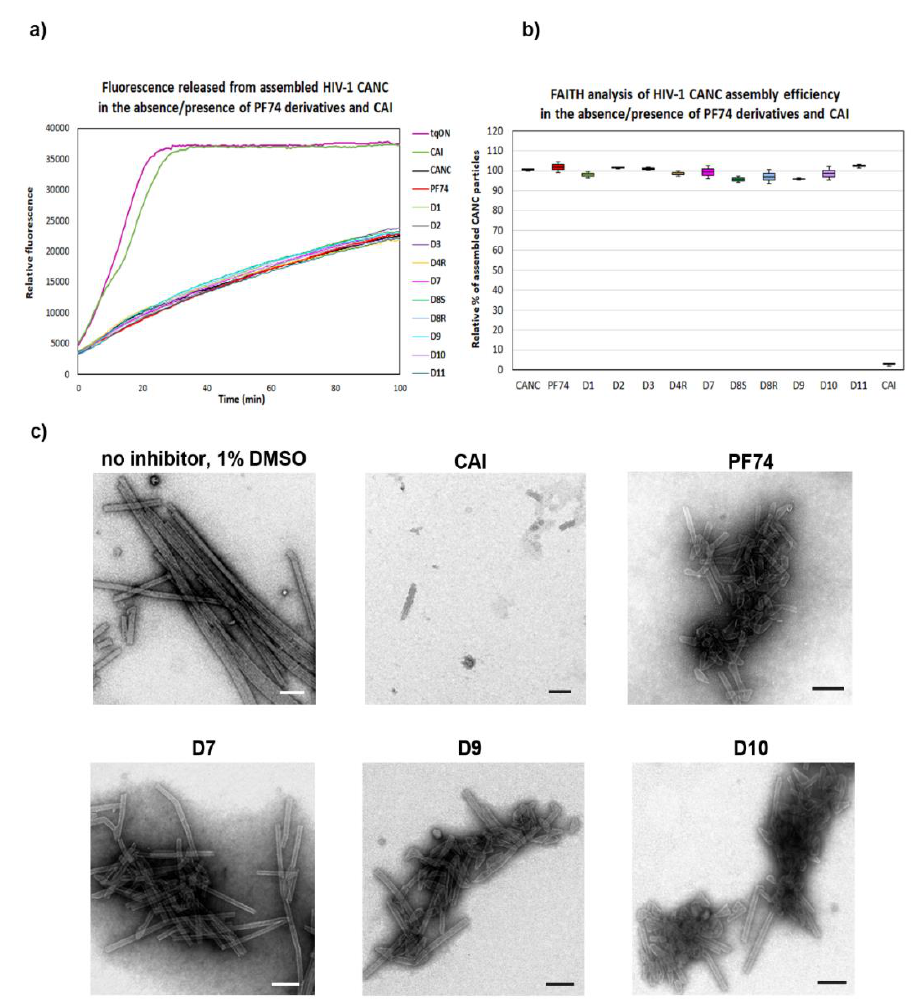
Figure 2. Quantification of the in vitro assembly of HIV-1 CANC in the presence of PF74 and its derivatives by Fast Assembly Inhibitor Test for HIV (FAITH). HIV-1 CANC (18 µM) was mixed with tqON (1.8 µM) CAI, and PF74 or its derivatives to a final concentration 10 µM. Following the assembly reaction, Exonuclease I was added to each sample to degrade free, non-incorporated tqON. ( a ) Fluorescence released from degraded tqON was monitored for tqON itself (purple), CANC without inhibitor (black) and from the sample containing. DMSO without inhibitor (black) and from the sample containing CAI (green), PF74 (red), D1 (light green), D2 (grey), D4R (yellow), D7 (pink), D8S (dark green), D8 (light blue), D9 (cyan), D10 (violet), and D11 (azure). ( b ) Assembly e ffi cacy was calculated from the di ff erence in relative fluorescence between the control represented by free tqON (panel a, purple curve) and the assembled CANC particles in the absence of an inhibitor (panel a, black curve) or in presence of inhibitors. The relative percentage of the e ffi cacy of HIV-1 CANC assembly in the presence of PF74 and its derivatives was compared to that of CANC, which was considered as 100%. ( c ) Following FAITH, in vitro assembled HIV-1 CANC in the presence of indicated inhibitors were negatively stained and analyzed by TEM. Bar represents 200 nm.